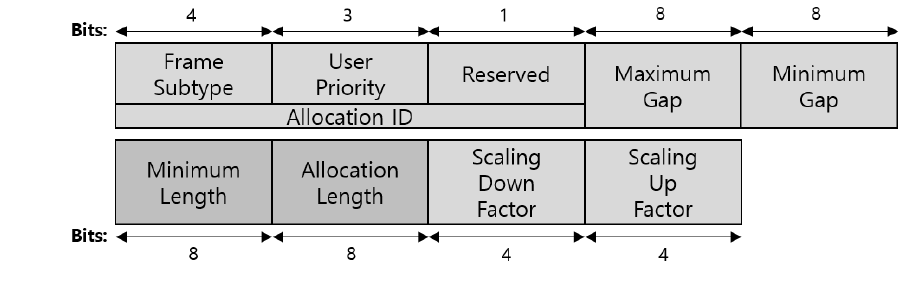
Figure 10. Allocation request